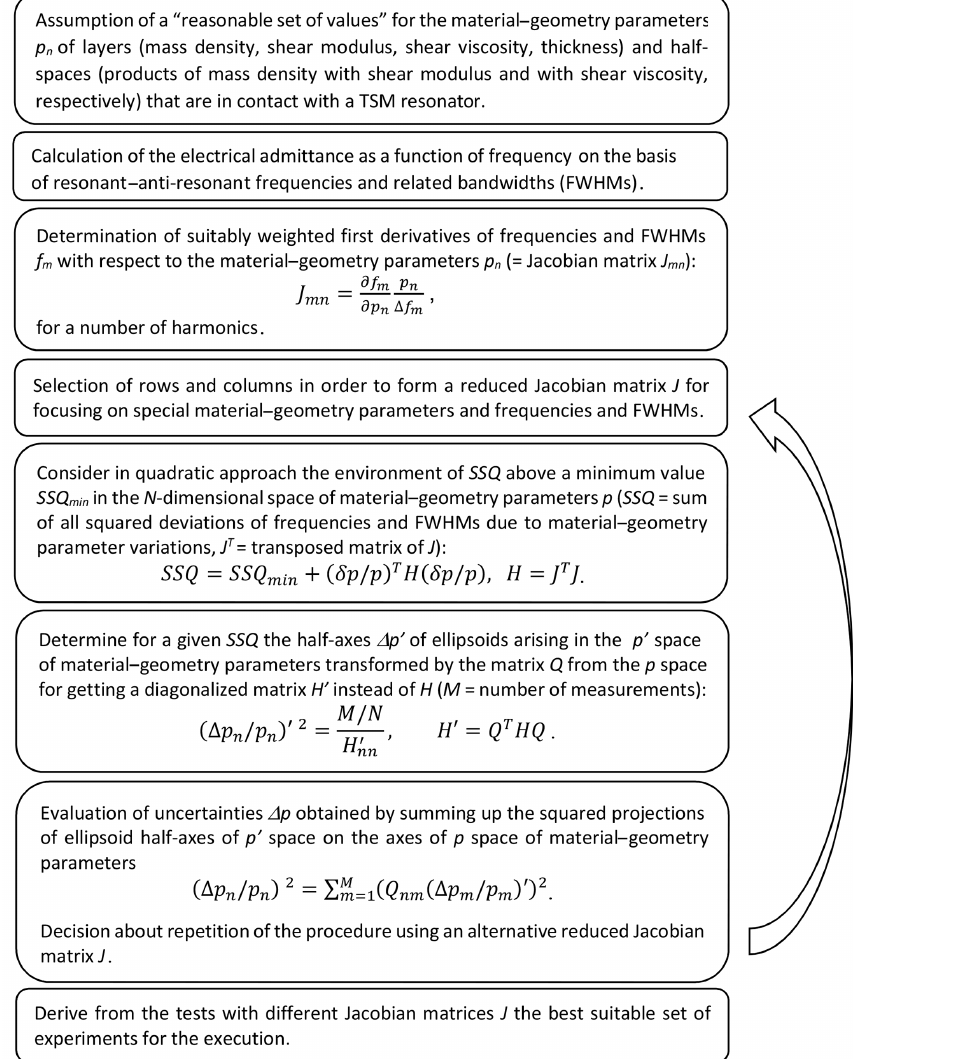
material–geometry parameters of the system, already consid- ered in Sect. 3.3 with respect to the achieved